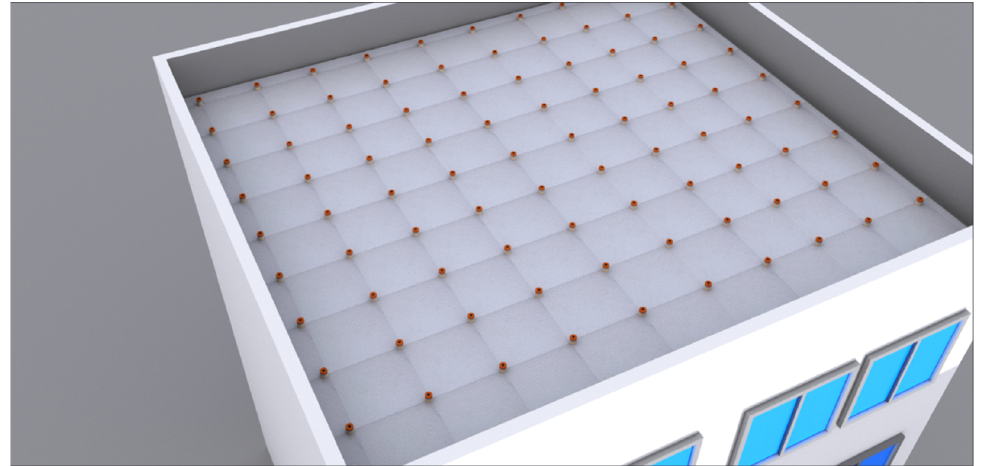
Figure 4. A 1 cm layer of polystyrene foam used to create a smooth surface for the upper layers.